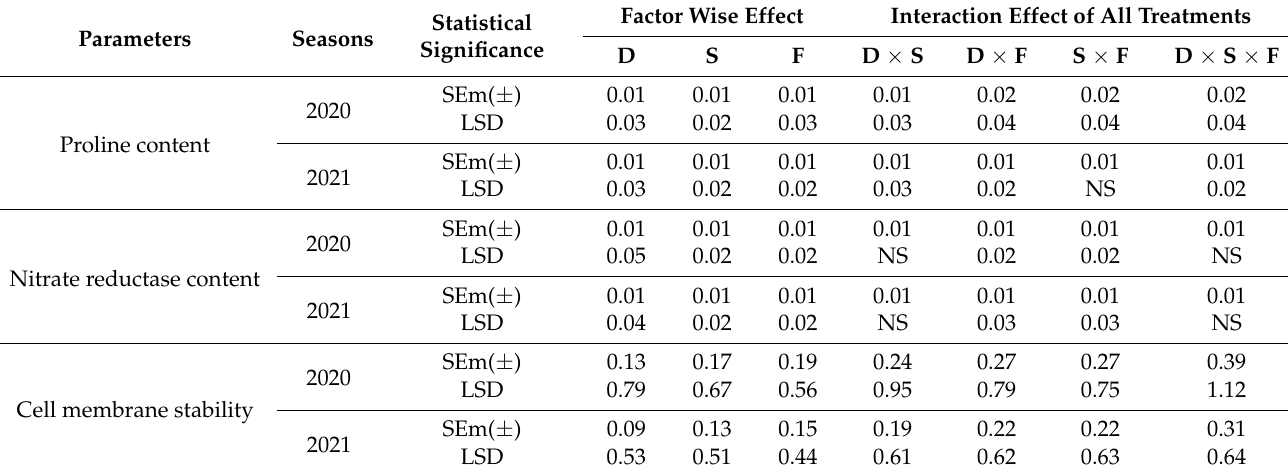
Table 10. Statistical significance and interaction effects of date of sowing, soil application of Co and foliar spray of K and B on the proline content, nitrate reductase content, and cell membrane stability of black gram during the spring–summer season.